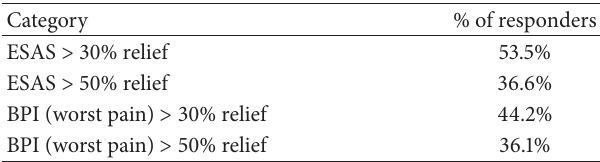
Table 2: Percentage of responders comparing baseline and FU 2